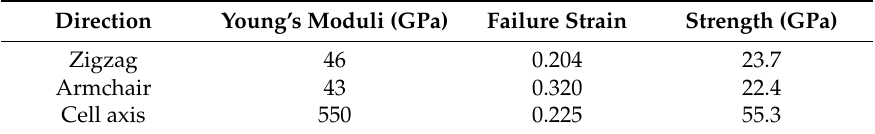
Table 1. Mechanical properties of carbon honeycomb for tensile loading along different direction.